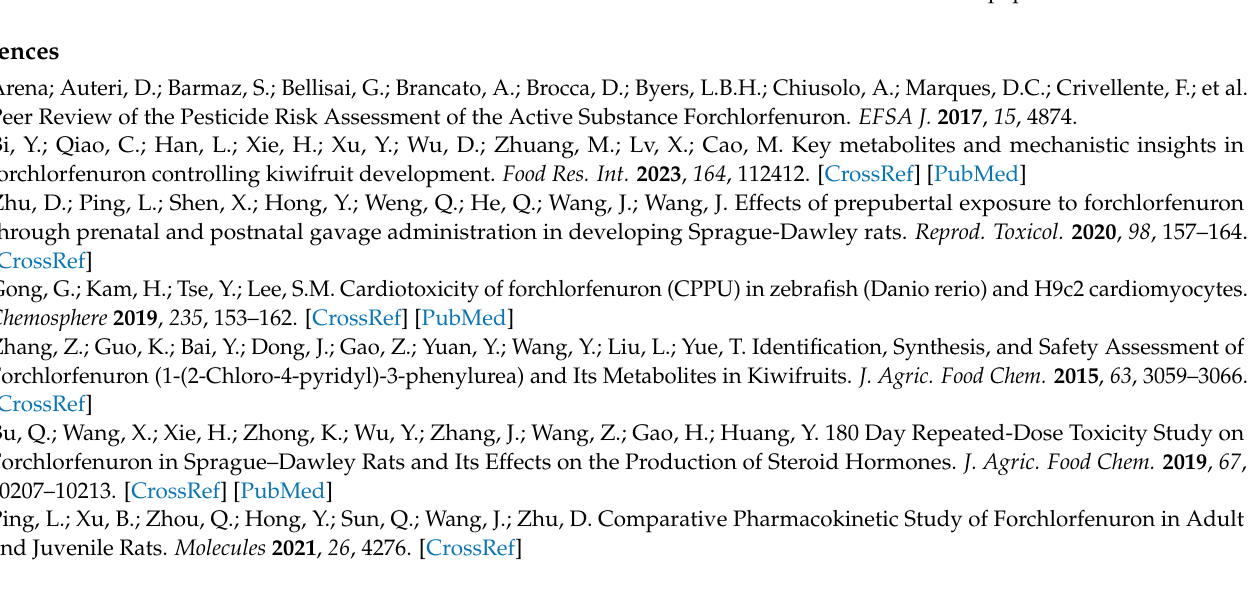
antibody 9G9; Table S7. The checkered ic-ELISA result of 9A10; Table S8. The checkered ic-ELISA result of 1B6; Table S9. Optimization of ic-ELISA with different organic solvent contents in PBSTG buffer. Table S10. Optimization of ic-ELISA with different pH values of PBSTG buffer; Table S11. LC-MS/MS detection conditions; Table S12. Anti-CPPU 9G9 mAb type; Figure S1. MALDI-TOF MS results of the immunogen (A) and coating antigen (B); Figure S2. Optimization of ic-ELISA with different organic solvent contents and pH values in PBSTG buffer: (a) methanol, (b) acetonitrile, and (c) pH; Figure S3. pH optimization of colloidal labeled antibody (the volume of K 2 CO 3 ); Figure S4. Optimization of coating antigen and secondary antibody concentration (coating antigen/secondary antibody: (1) 2 and 1 mg/mL, (2) 1.5 and 0.8 mg/mL, (3) 3 and 0.4 mg/mL, (4) 4 and 0.2 mg/mL); Figure S5. Organic solvent content on the strip: (a) methanol, and (b) acetonitrile; Figure S6. Test stability of CGN-ICTS (a) CK (b) 50